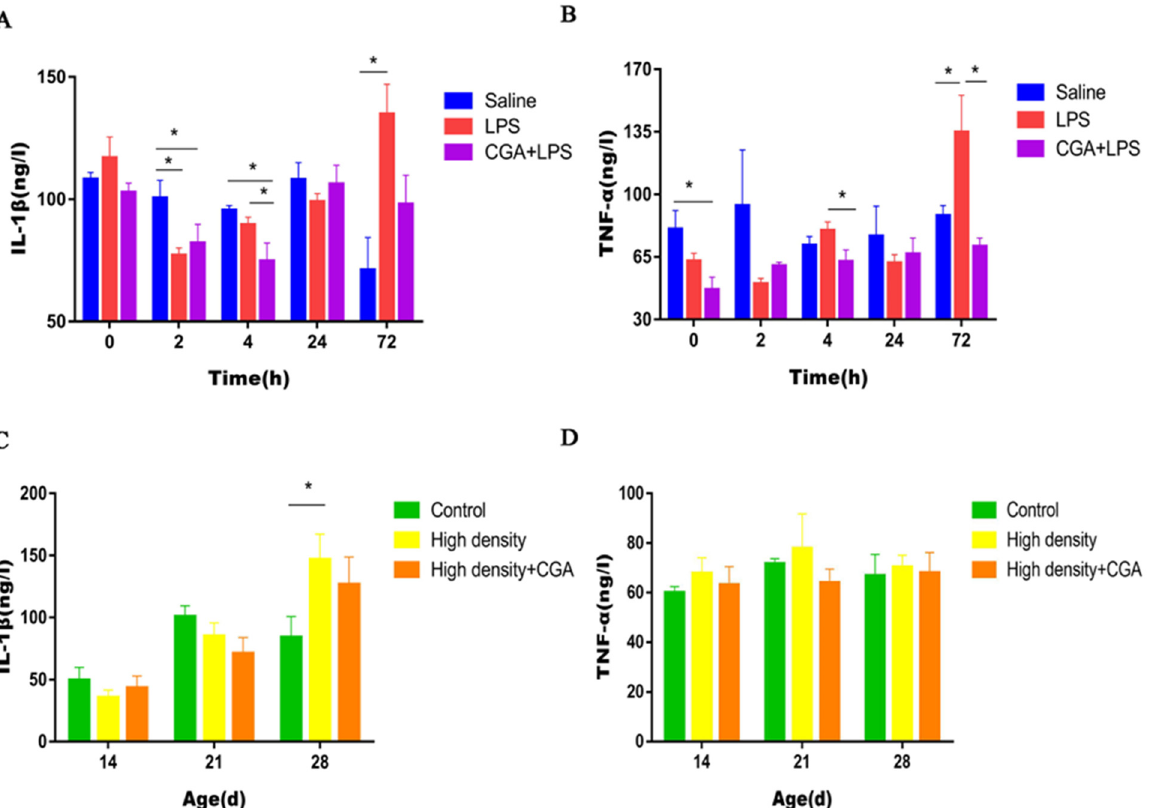
Figure 5. Effects of chlorogenic acid on serum cytokine levels of broilers challenged with immune stress and high density stress. ( A ) IL-1 β levels of broilers challenged with immune stress. ( B ) TNF- α levels of broilers challenged with immune stress. ( C ) IL-1 β levels of broilers challenged with high density stress. ( D ) TNF- α levels of broilers challenged with high density stress. IL = Interleukin, TNF- α = tumor necrosis factor- α , * means significant difference between groups.